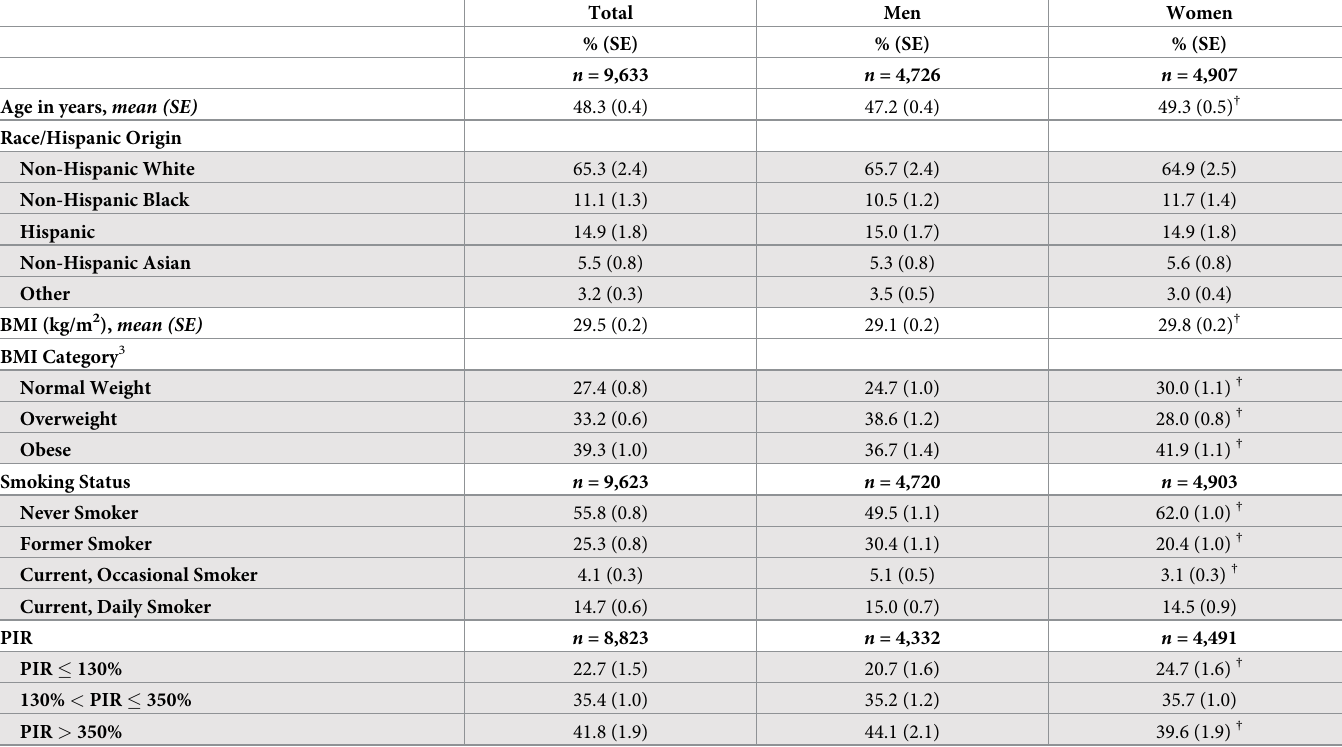
Table 2. Demographic characteristics of study population, NHANES 2013–2016 1,2